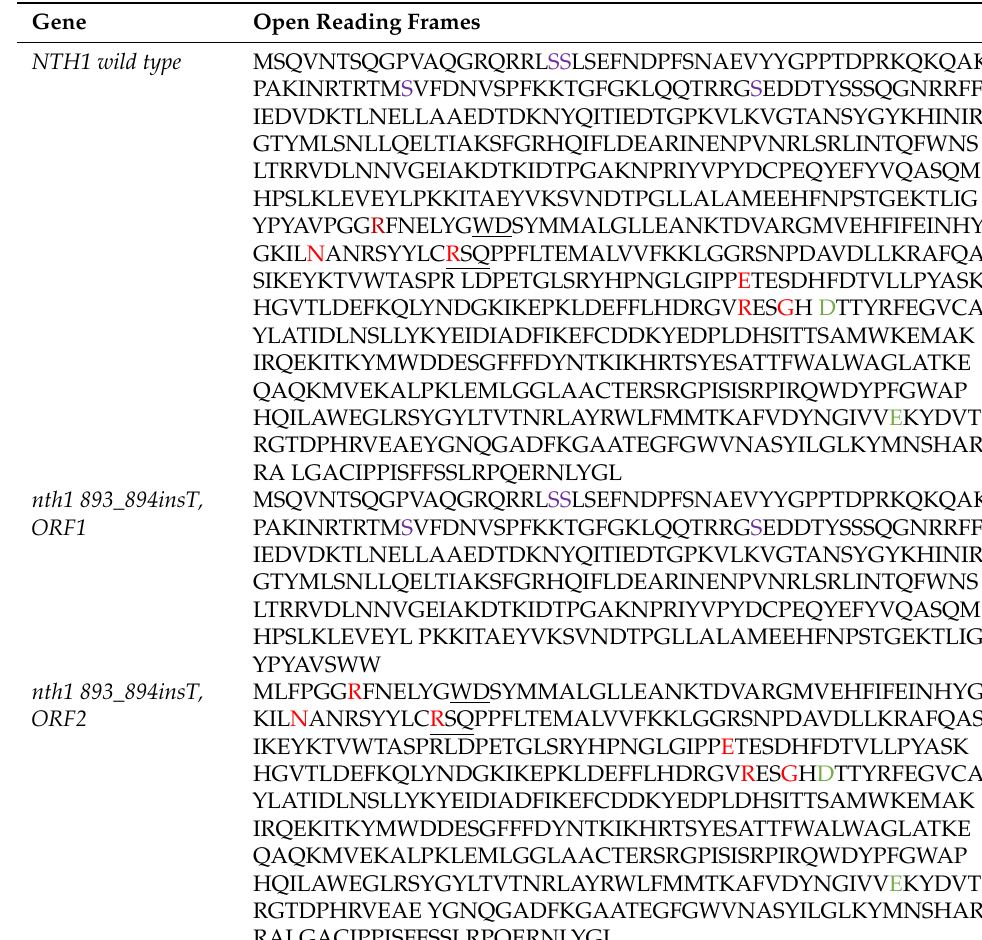
DEFKQLYNDGKIKEPKLDEFFLHDRGVRESGHDTTYRFEGVCAYLATIDLNSLLYKYEIDIADFIKEFCDDKYEDPLDHSITTSAMWKEM